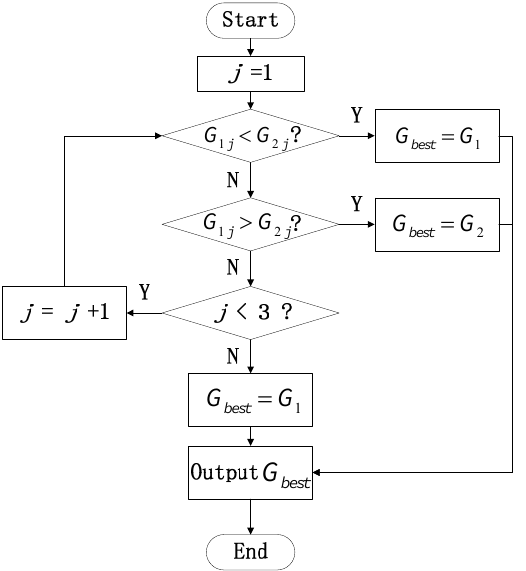
Figure 7. Flowchart of the fitness comparison based on vectorial